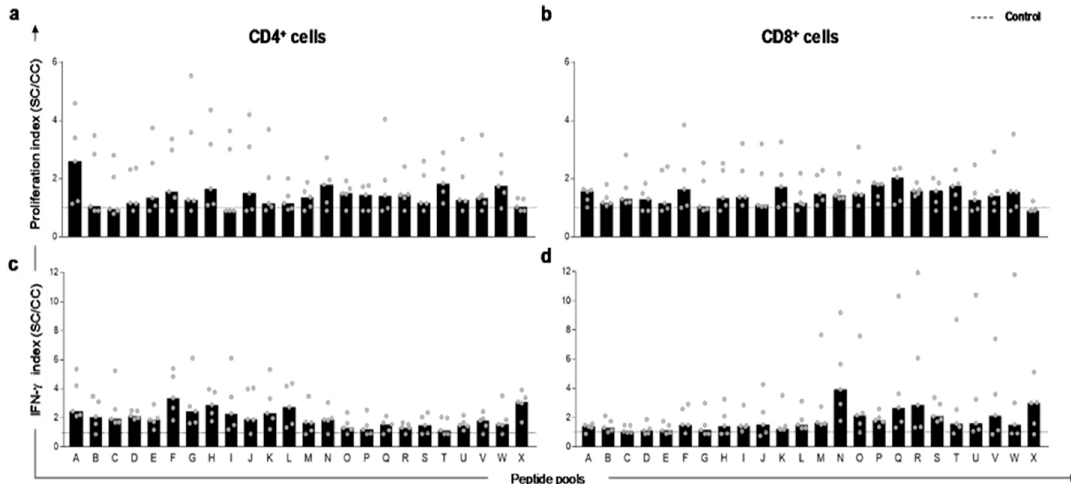
Figure 1. In vitro proliferation and IFN- γ production by T-lymphocytes in peripheral blood mononuclear cells (PBMC) of L. infantum naturally infected dogs after stimuli with predicted peptides. The spots represent indexes of T-cell responses to Leishmania infantum peptide pools in PBMC of naturally infected and asymptomatic dogs ( n = 5 in gray circles). Proliferation index of CD4 + ( a ) and CD8 + ( b ) lymphocytes after peptide pool stimuli. ( c ) Index of IFN- γ producing by CD4 + and CD8 + ( d ) lymphocytes after peptide pool stimuli. Indexes were calculated based on SLA (soluble Leishmania antigen)-stimulated (SC) cultures divided by the control culture (CC). Cut-off (dashed line) for responses was calculated by the control culture indexes (cut-off = 1).